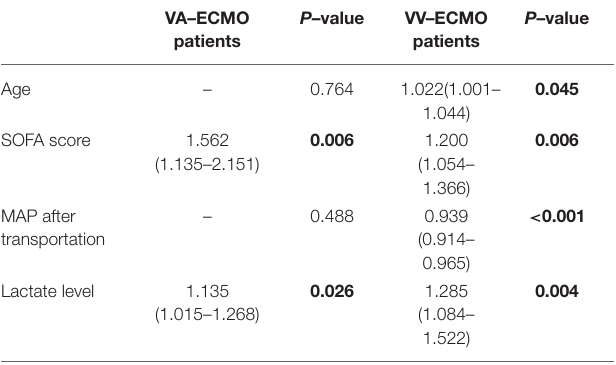
TABLE 5 | Cox regression survival analysis of VA–ECMO and VV–ECMO patients.